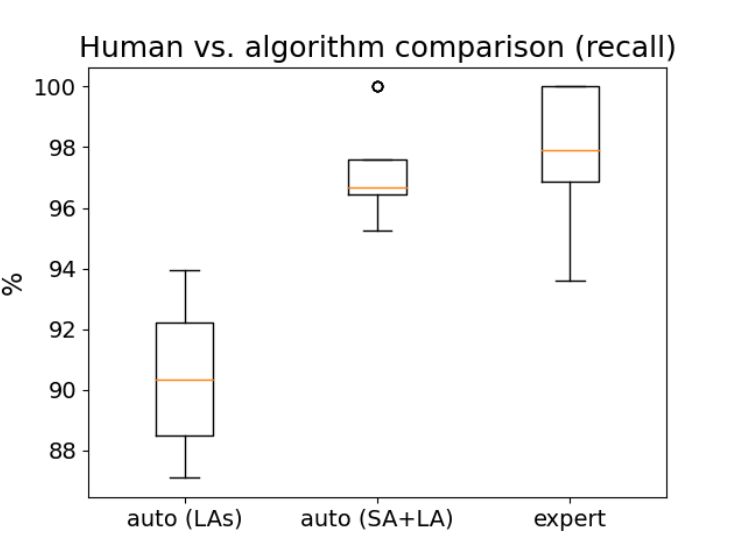
Figure 6. Comparison of the human (expert) and algorithm (auto) performances. High recall is beneficial because the algorithm can identify samples suspicious of hypertrophy with a high probability. The false positives can be handled by the experts who supervise the examination. The p - value is less than 0.001 between the auto (LA) and auto (SA+LA) groups. When comparing auto (SA+LA) and the expert groups, we obtained a p -value = 0.3, indicating there was no statistically significant difference between them. Therefore, the auto (SA+LA) was statistically identical to the expert group in terms of the